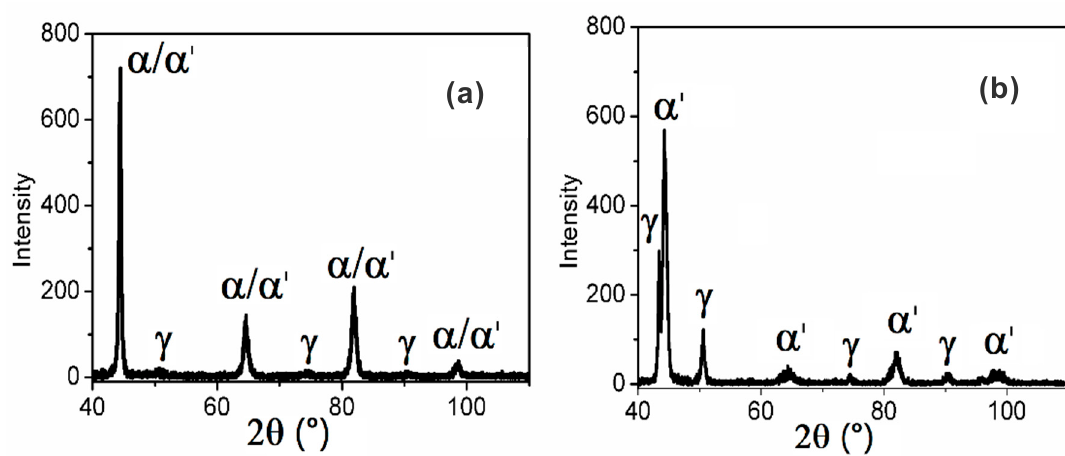
Figure 3. X-ray diffractograms of ( a ) as-cast and ( b ) homogenized samples. Figure 3. X-ray di ff ractograms of ( a ) as-cast and ( b ) homogenized samples.